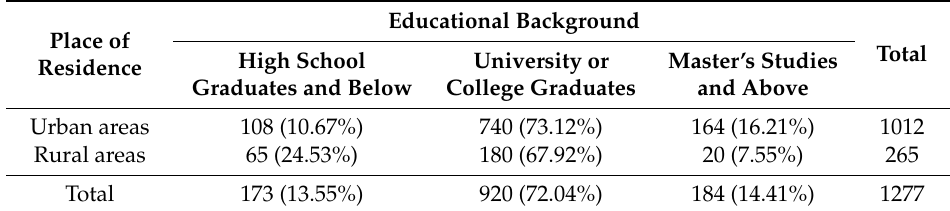
Table 2. Cross-analysis of educational backgrounds between parents from urban and rural areas in Beijing.